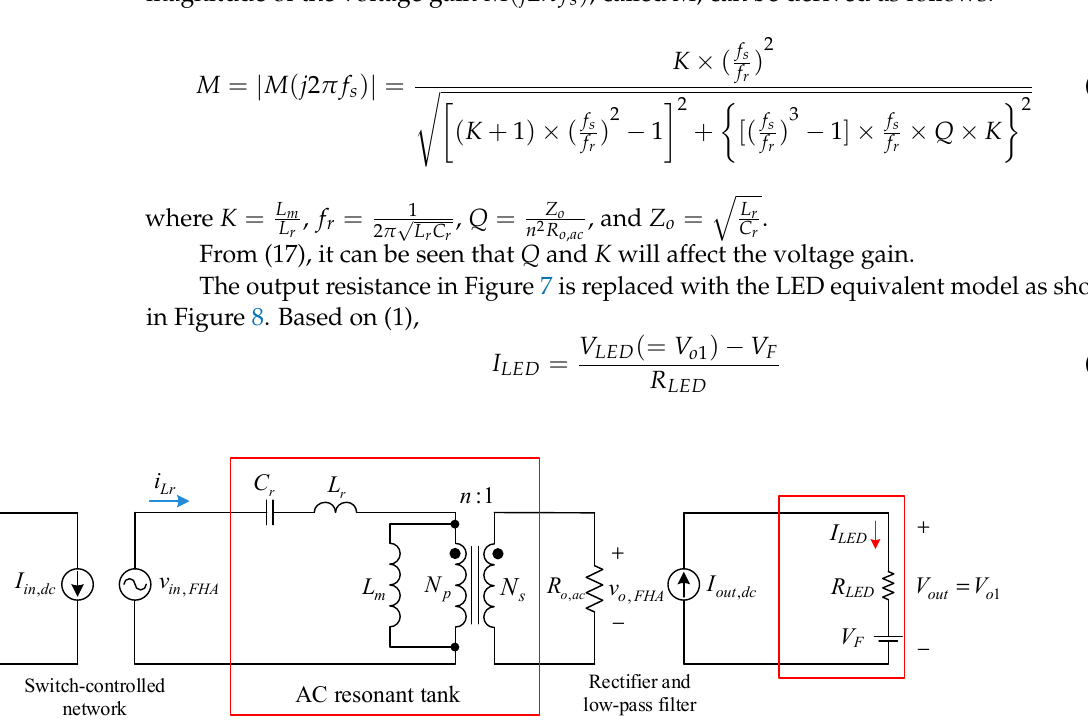
Figure 8. Two-port model of the FHA resonant circuit with one LED string at the output terminals. Based on (16), Equation (19) can be rewritten